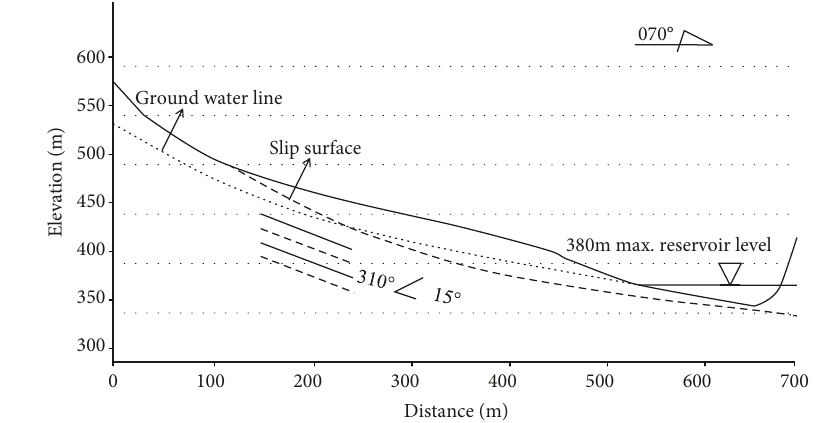
Figure 6: Cross-section of Dasha landslide (A-B).